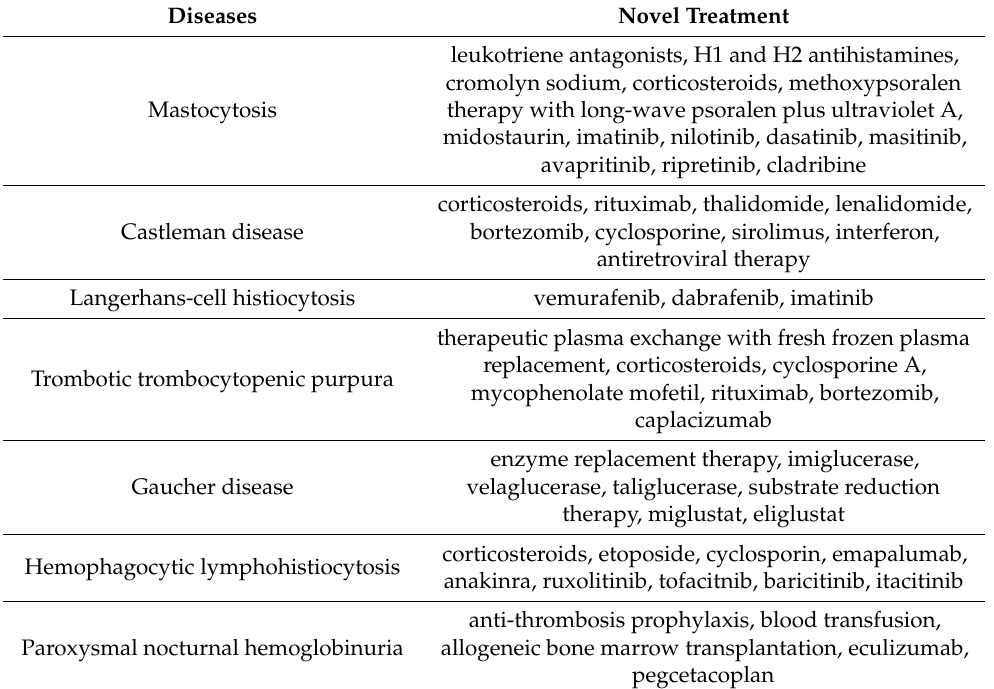
Table 2. Examples of methods of treatment of rare diseases in